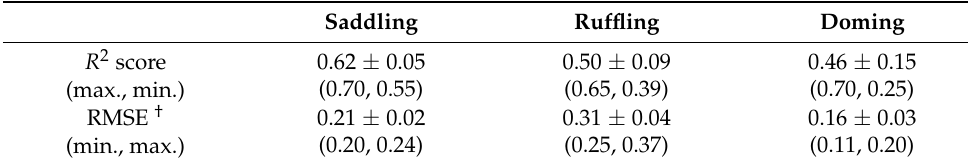
Table 2. The results of the prediction by the input voxels with the edge length of 24 Å. The mean value and standard deviation of R 2 score, and RMSE values are listed. Saddling Ruffling